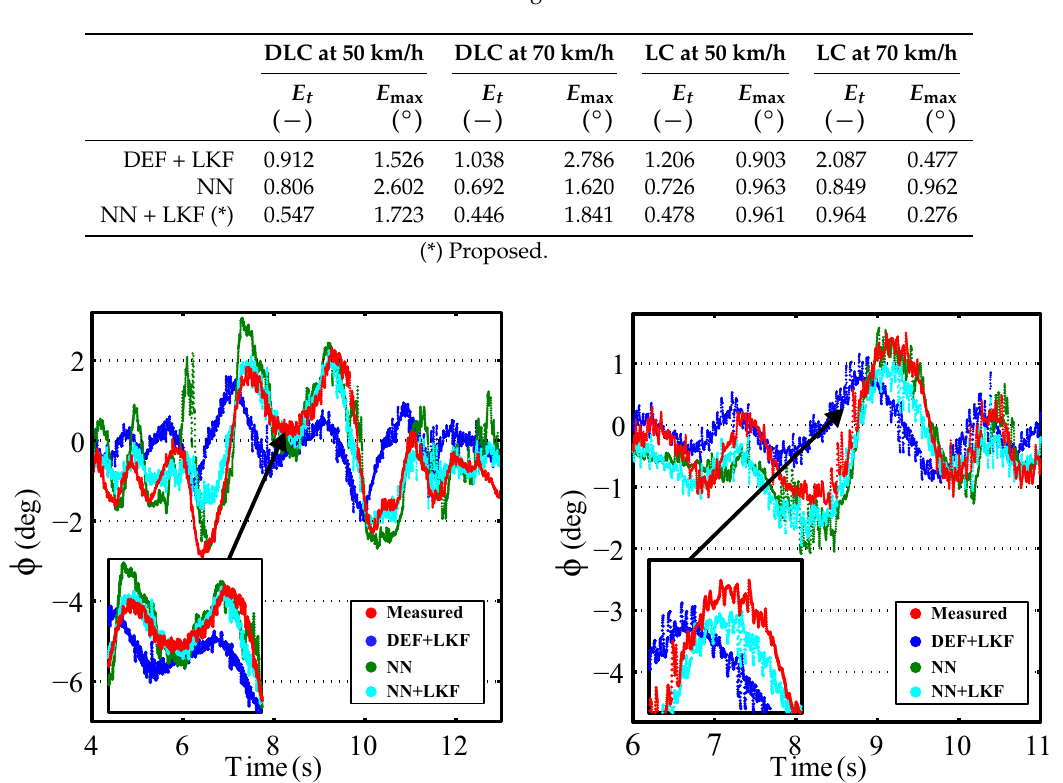
Table 5. Norm and maximum errors for roll angle estimators for the DLC and LC maneuvers.